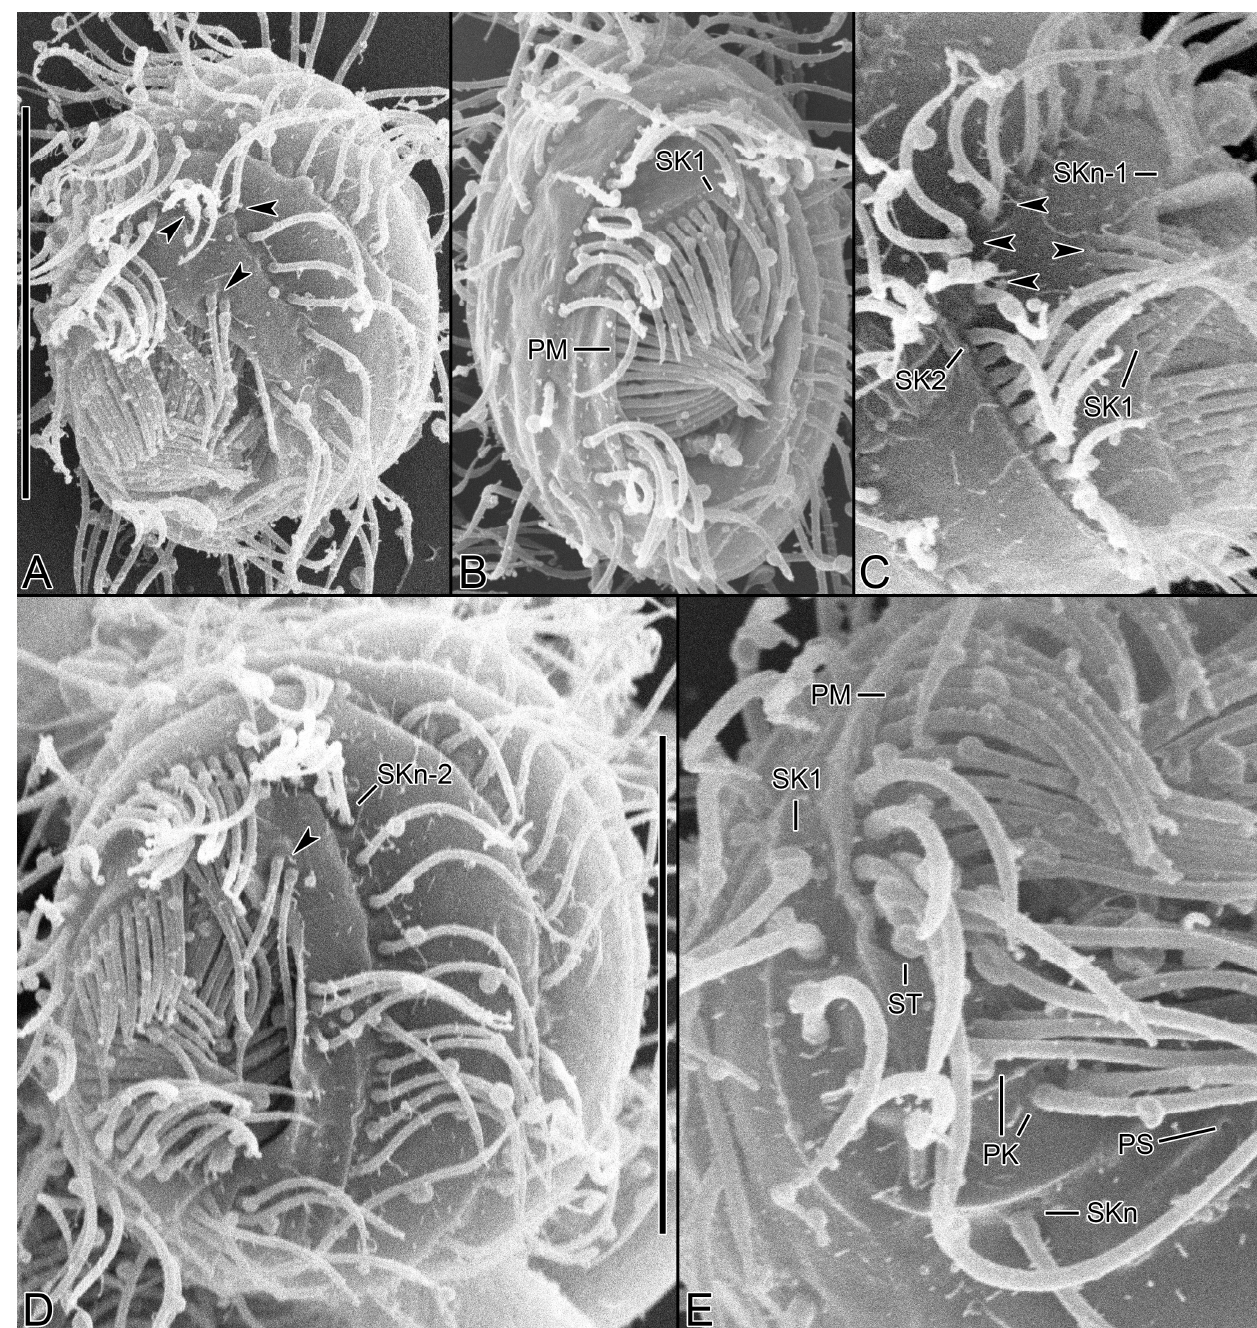
Figure 8. Cinetochilides minimus sp. nov. in the scanning electron microscope. ( A – E ). Ventral views showing the body shape, oral apparatus, and ventral ciliature. Arrowheads denote the dikinetids in somatic kineties n-1 and n-2 and all kinetosomes are ciliated. PK, postoral kineties; PM, paroral membrane; PS, parasomal sacs; SK, somatic kineties; ST, scutica. Scale bars: 10 µm.